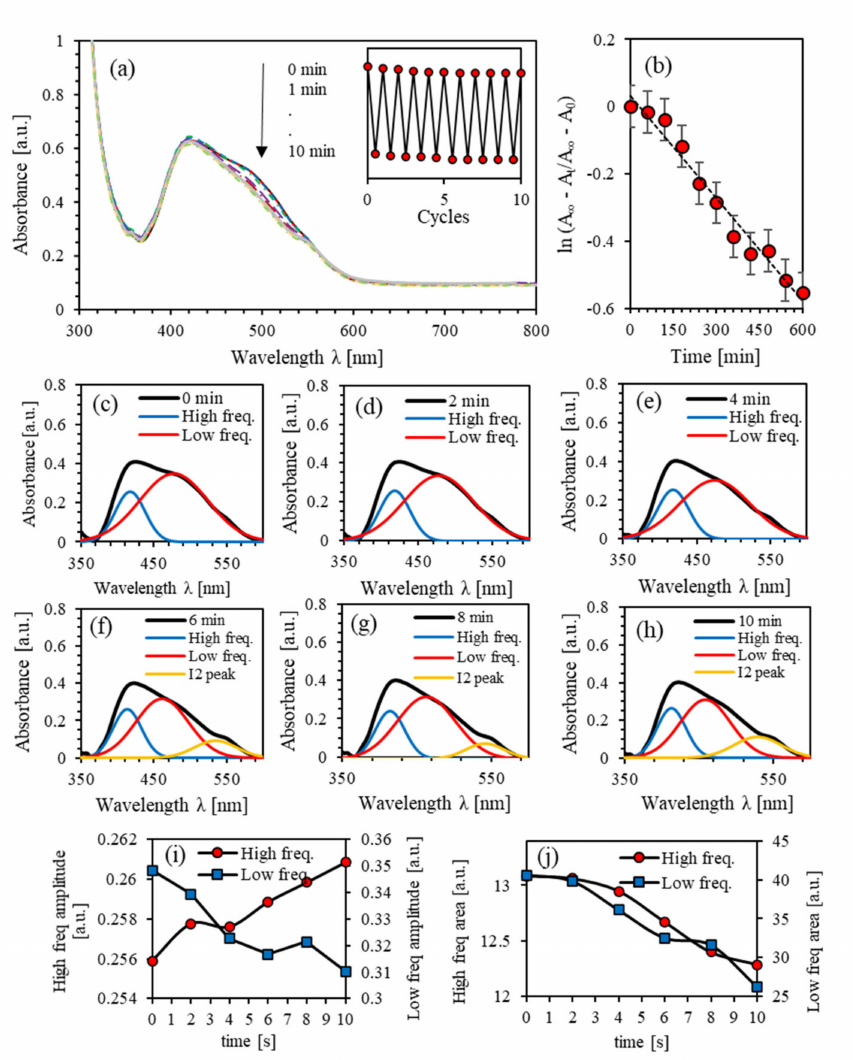
Figure 10. ( a ) Absorbance spectra of (PEO-BDK-MR)/I 2 (10%) complex composite thin film for various UV-illumination times, ( b ) the kinetic constants for trans → cis photoisomerization of (PEO- BDK-MR)/I 2 (10%) complex composite thin film, ( c – h ) Double peaks fit for the absorbance spectra of (PEO-BDK-MR)/I 2 (10%) complex composite thin film for various UV-illumination exposure periods, ( i ) The amplitude and ( j ) integrated area-fit for the dual-peaks of the absorbance for the (PEO-BDK-MR)/I 2 (10%) complex composite thin film for various UV-light exposure periods. Figure 11 shows the FTIR spectra for the trans - and cis -states of (PEO-BDK-MR)/I 2 (10%) in the spectral range of 400–4000 cm − 1 . As was found for (PEO-BDK-MR)/I 2 (0.1%) film, the intensive N=N band for the cis -MR is compared to that of trans -MR, indicating the enhanced photoisomerization for the trans -state to cis -state